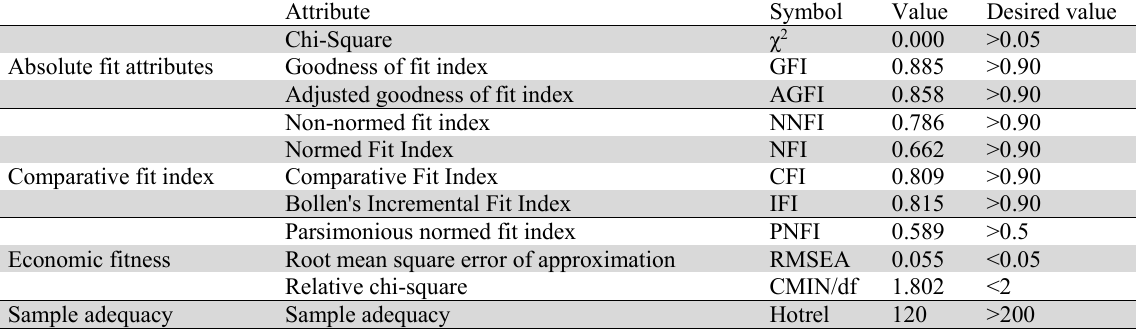
The results of statistical observations